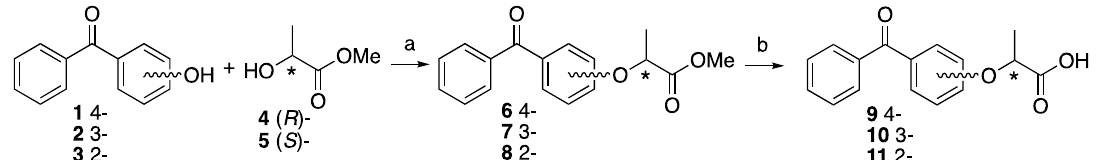
Figure 2. Synthesis of benzophenone-containing lactisole derivatives. ( a ) (1) PPh 3 , CH 2 Cl 2 , 0 °C, 10 min; (2) diethyl azodicarboxylate (DEAD), CH 2 Cl 2 , rt, 8 h, ( S )- 6 88%, ( R )- 6 quant., ( S )- 7 quant., ( R )- 7